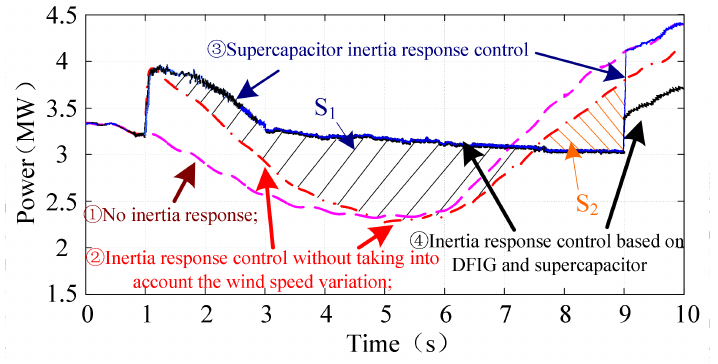
Figure 13. Comparison of the total frequency inertia response power of wind farms under different control strategies.